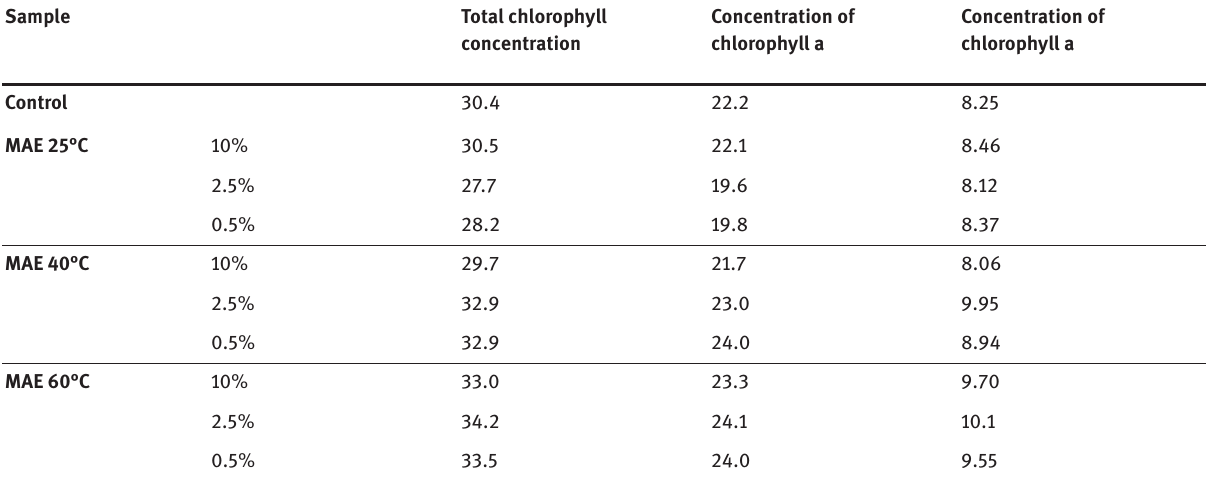
Table 4: Chlorophyll concentration in the cultivated cress (mg L -1 ).